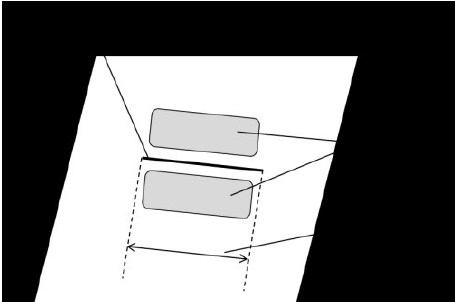
Figure 4. Matching parameters